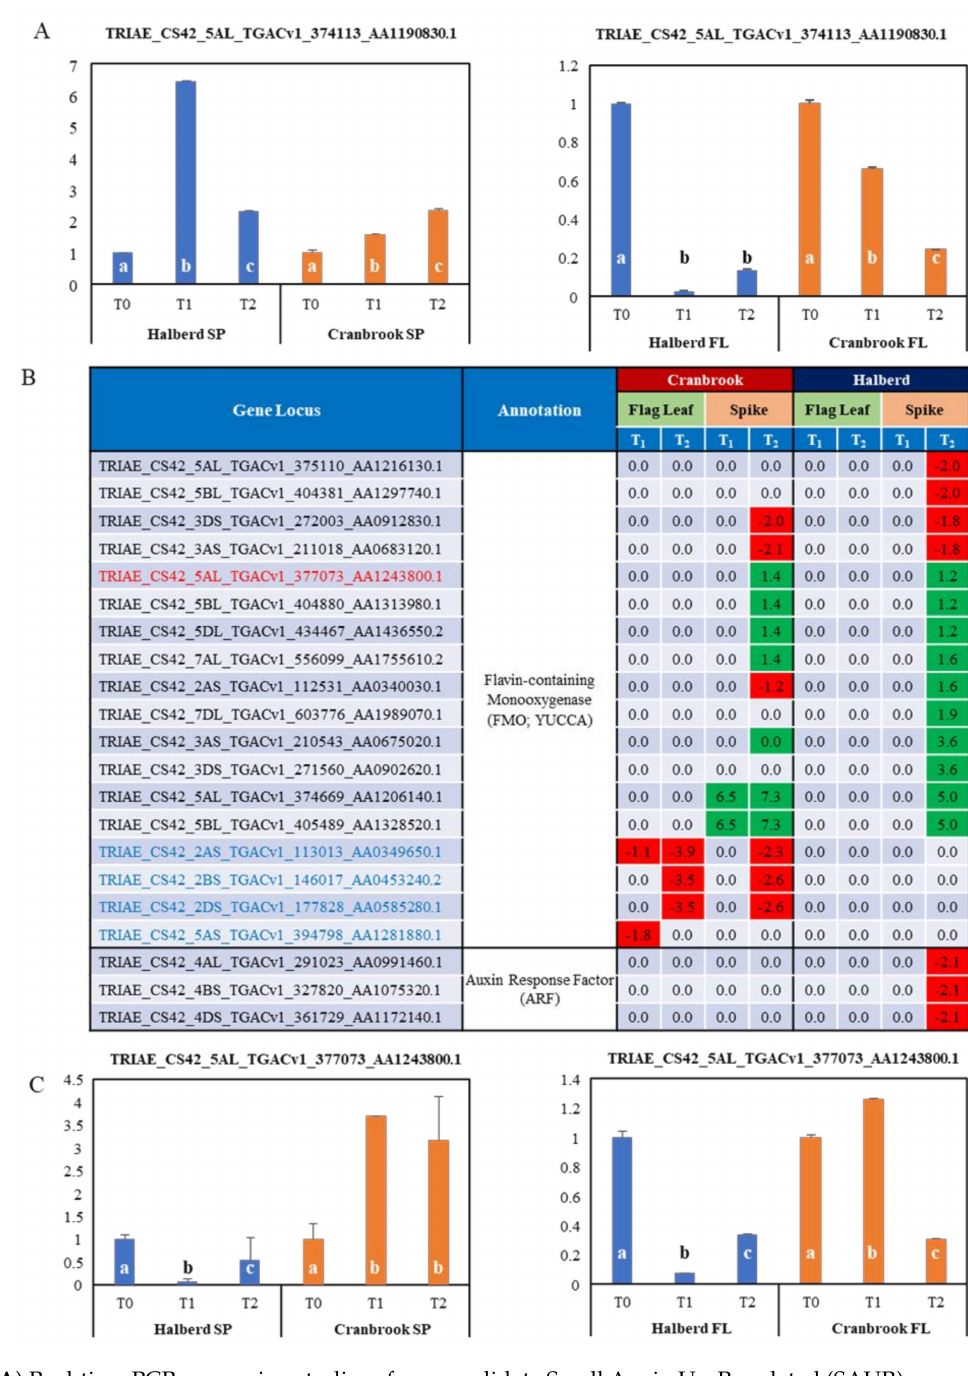
Figure 7. ( A ) Real-time PCR expression studies of one candidate Small Auxin Up-Regulated (SAUR) gene. Three repeat samples were tested and error bars show standard errors. Gene expression levels are relative to the unstressed control (=1) for each wheat line and bars in the graph labelled with different letters are significantly different ( t -test; p < 0.05). ( B ) List of enriched genes potentially encoding flavin-containing monooxygenase (FMO; YUCCA; 18 genes) involved in auxin biosynthesis, and genes encoding Auxin Response Factors (ARF; three genes) transcription factors. The expression data are listed as Log FC values relative to unstressed plants (green = up-regulated; red = down-regulated). ( C ) Real-time PCR expression studies of one candidate FMO gene. Three repeat samples were tested and error bars show standard errors. Gene expression levels are relative to the unstressed control (=1) for each wheat line and bars in the graph labelled with different letters are significantly different ( t -test; p <